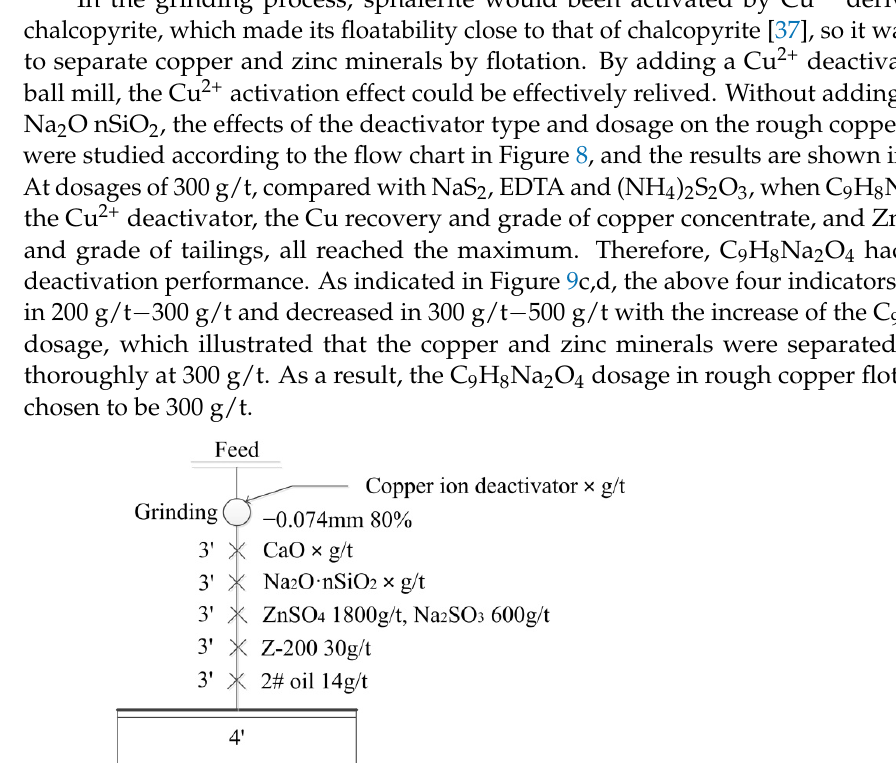
Figure 9. Effects of deactivator type ( a , b ) and dosage ( c , d ) on rough copper flotation. Under weak alkaline conditions, Z-200 had a better collecting performance for chalcopyrite [38], so CaO was usually added into the pulp. Without adding the Cu 2+ de- activator and Na 2 O nSiO 2 , the influence of the CaO dosage on rough copper flotation was studied. The experimental flow chart is shown in Figure 8, and the results are given in Figure 10a,b. The Cu recovery and grade of concentrate and Zn recovery of tailings all first increased and then decreased with the increase of CaO dosage, they reached the